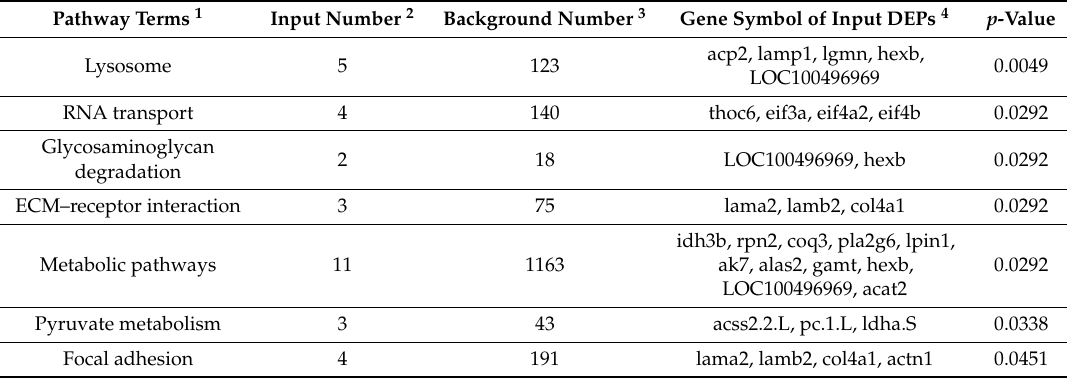
Table 3. KEGG enrichment analysis of